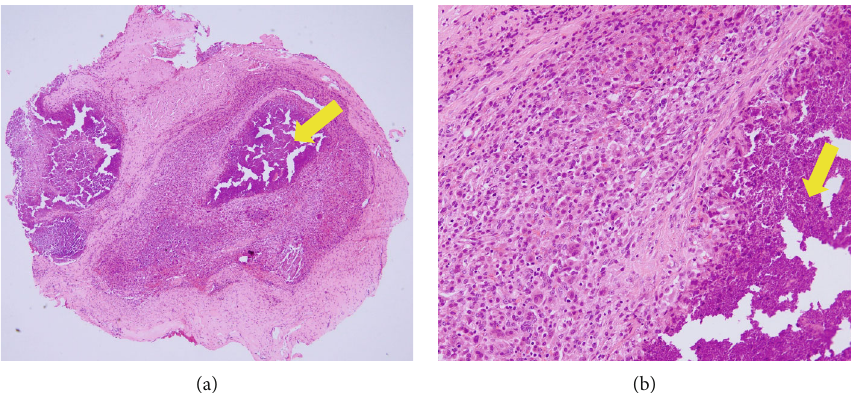
Figure 3: Hematoxylin and eosin staining. (a) Low power view (4x magni fi cation). (b) High power view (20x magni fi cation). Sections of the obtained specimen reveal multifocal massive deposition of calci fi ed amorphous material (yellow arrow), which is surrounded by a thick layer of foreign body granuloma.